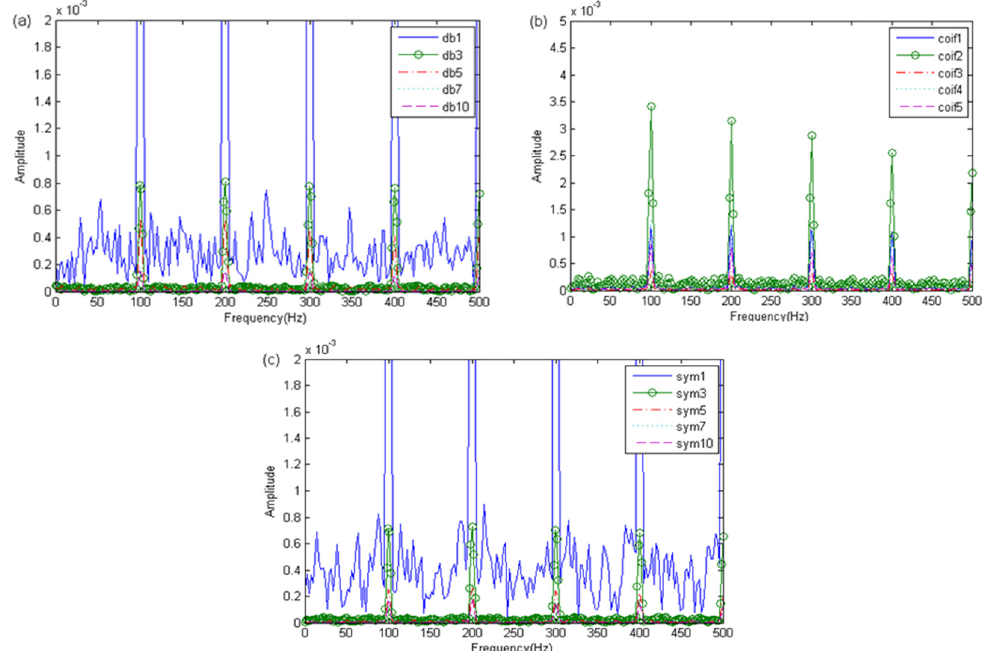
Figure 2. The results of the envelope analysis: ( a ) dbN; ( b ) coifN; ( c ) symN.